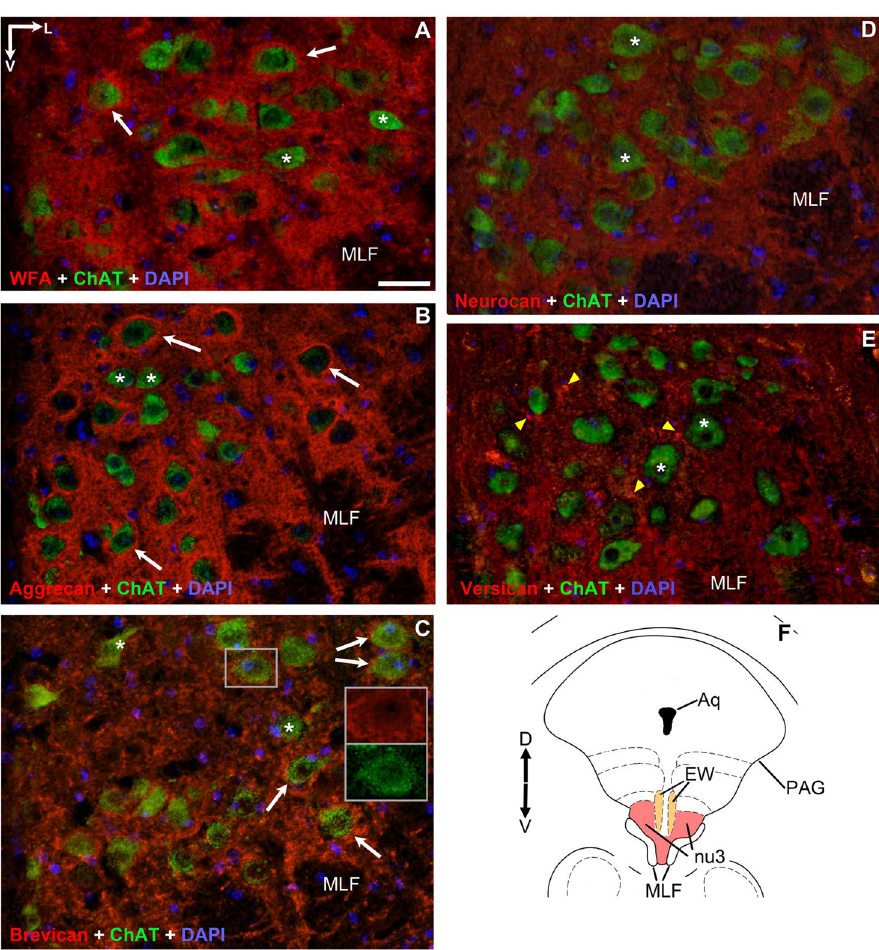
Figure 1. Pattern of chondroitin sulfate proteoglycans around acetyl-cholinergic motoneurons (green) in the oculomotor nucleus . The nuclei were detected with DAPI. PNNs (red) were immuno-positive with WFA and aggrecan labeling (white arrows) ( A , B ). PNNs were absent around only the minority of cholinergic motoneurons labelled with WFA and aggrecan ( A , B ), and were entirely absent with brevican, neurocan and versican immuno-staining (asterisks) ( C – E ). Nevertheless, rod-like brevican accumulations gathered in the proximity of some motoneurons ( C ), although PNNs did not assemble. Somata in ( C ) appear in yellow tone due to the co-labelling of the cytoplasmic brevican and acetylcholine. In ( E ) dot-like accumulations of versican characterized the neuropil (yellow arrowheads). ( F ) Position of oculomotor- (nu3) and Edinger-Westphal (EW) nuclei in the mesencephalon (modified after Paxinos and Franklin 35 ) Aq: cerebral aqueduct. MLF: medial longitudinal fasciculus. PAG: periaqueductal gray matter. D: dorsal. V: ventral. L: lateral. Scalebar: 10